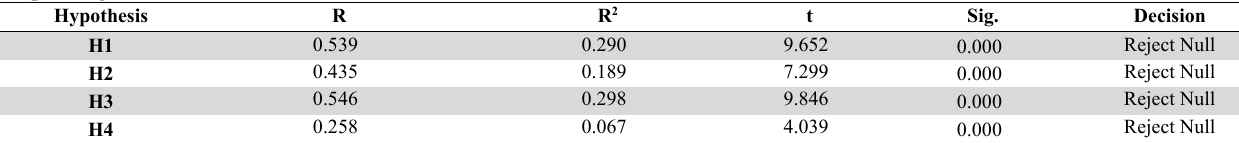
Simple Regression